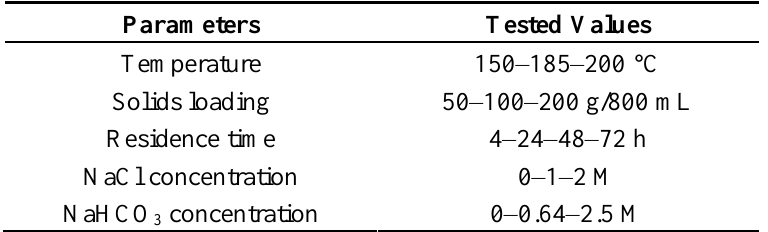
Table 2. Parameter values used in the carbonation